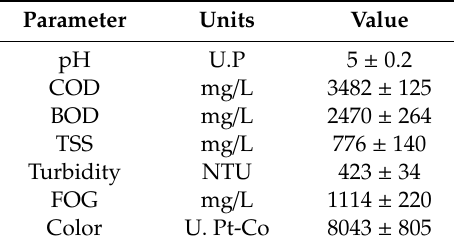
Table 3. Characteristics of cold meat industry wastewater.